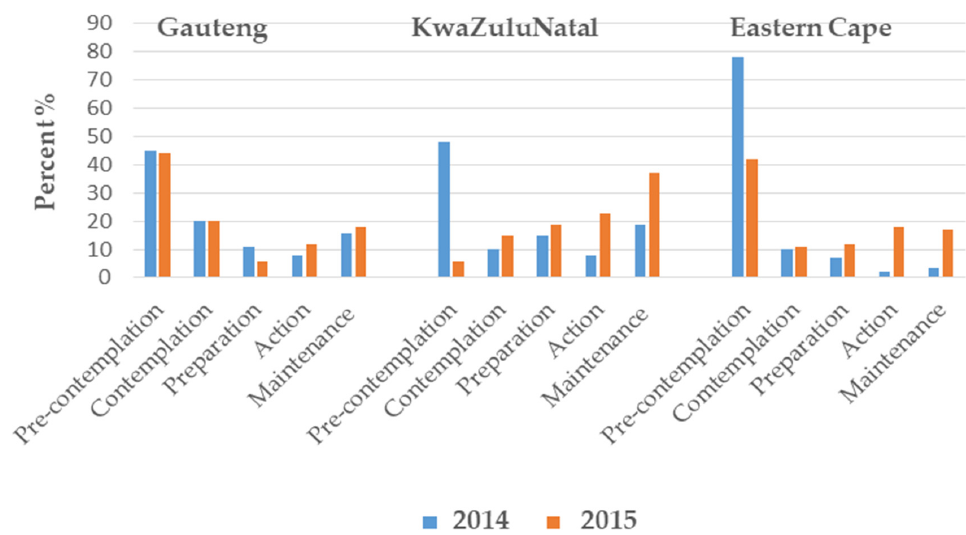
Figure 1. Percentage of participants in the various stages of change of salt consumption before and after the intervention in each region. The stages of change in salt consumption categories: pre ‐